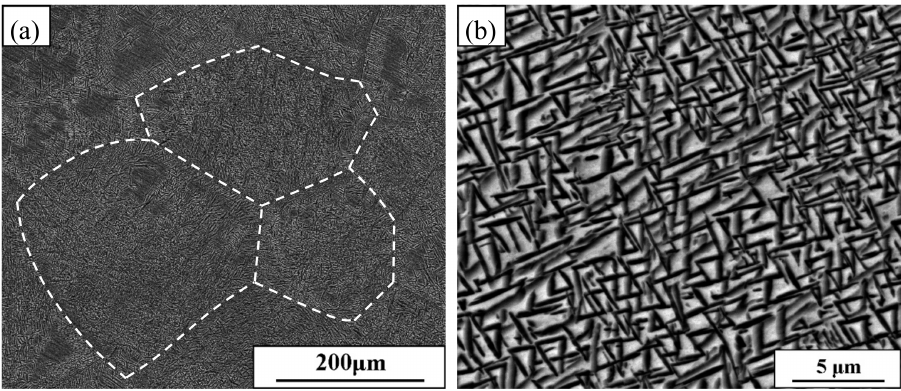
Figure 1. SEM micrograph of the heat-treated Ti-55531.